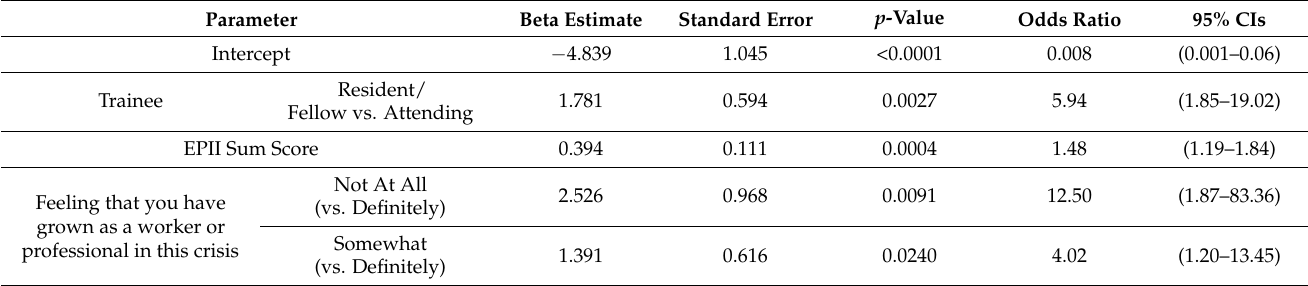
Table 4. Multivariable Model for Burnout—Emotional